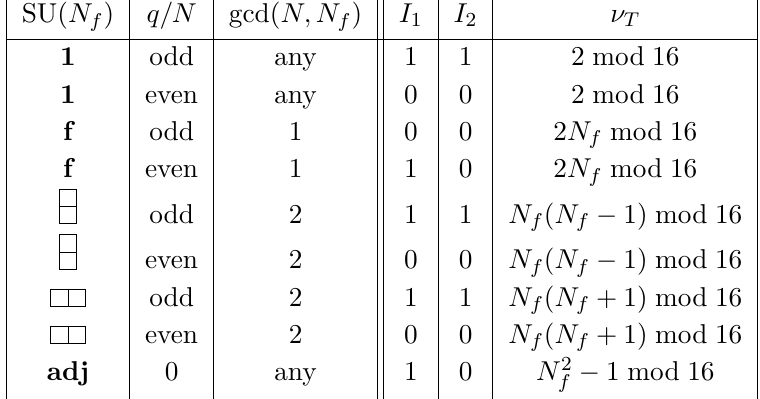
Table 1 . Indices for fermions in some representations of U ( N f ) / Z N in the fermionic theory. The representations of U ( N f ) / Z N R q are given in terms of the SU( N f ) representations R and the U(1) charge q .